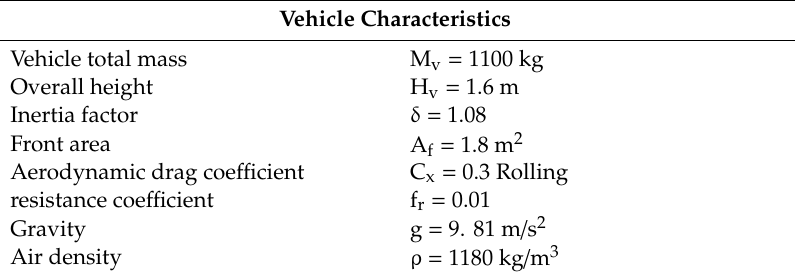
Table 1. Design specification and environment parameters.